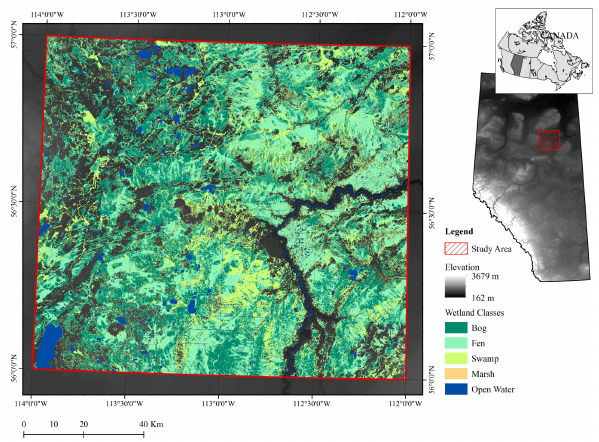
Figure 1. Map showing the location of the study area within northeastern Alberta, Canada, and the distribution of bogs, fens, swamp, marsh, and open water according to the Alberta Merged Wetland Inventory